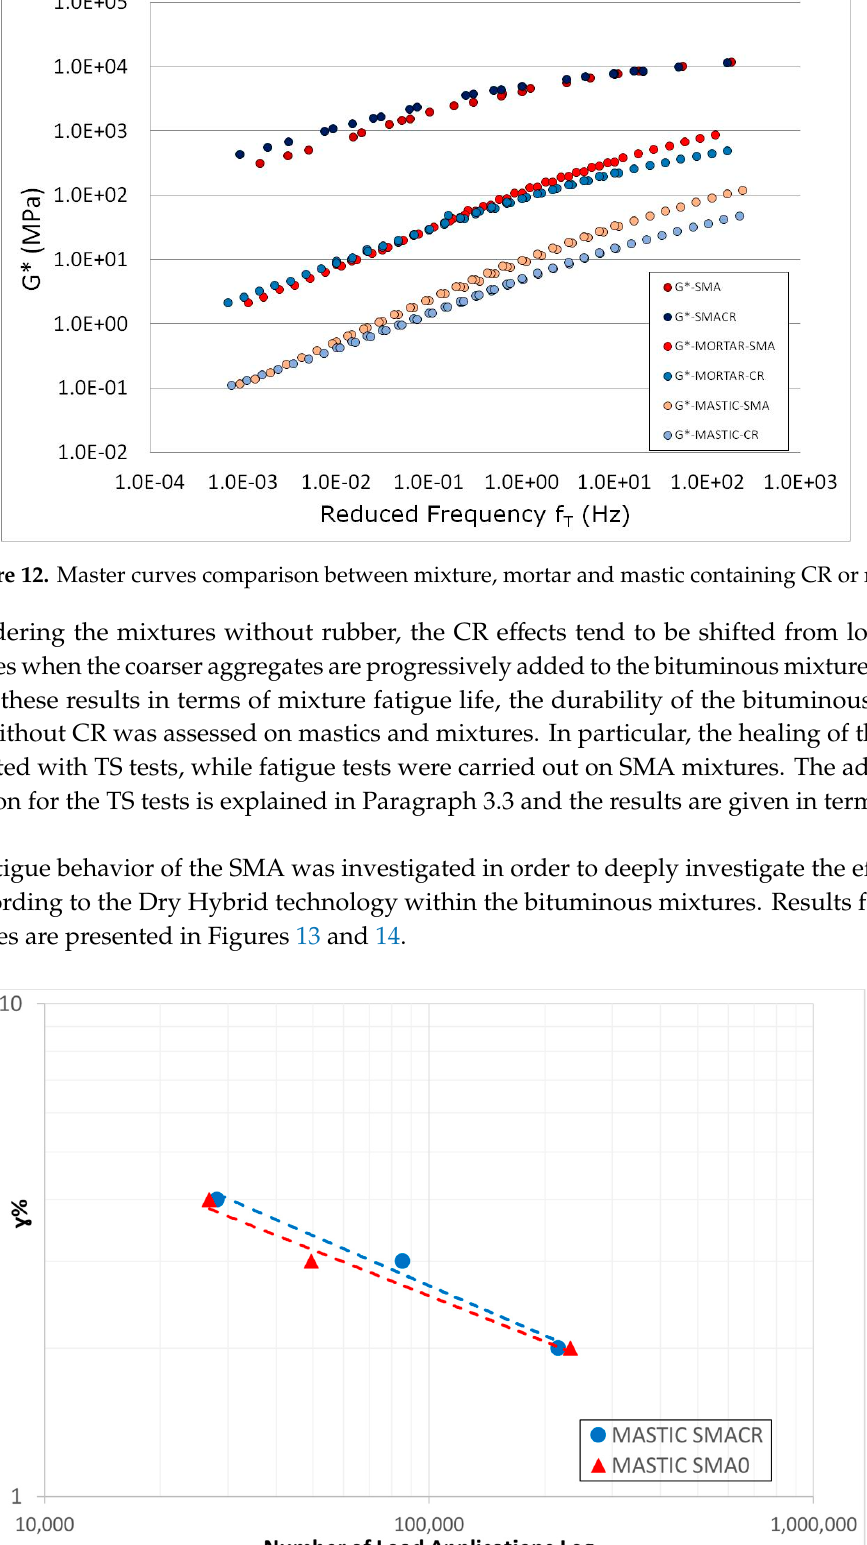
Figure 14. Mixtures indirect tensile fatigue test (ITFT) test comparison. From the analysis of results, the increase in number of load applications for both SMACR mastic and mixture is clear. The presence of CR involves the improvement of mastic and mixture durability regardless the applied stress. The phenomenon is confirmed in terms of healing (TS test on mastics) and fatigue life (ITFT on mixtures). It is worth noting that in terms of the stiffness modulus, both mixtures show comparable values (3259 MPa for SMACR and 3188 MPa for SMA0 at 20 °C, calculated according to EN 12697-26 Annex C standard). In the light of the above, the adopted stress levels produced comparable horizontal deformations in the samples, validating the adopted test conditions. 6. Conclusions The main objective of this study was to evaluate the rheo-mechanical properties of mastics, mortars and mixtures containing fine CR according to the dry-hybrid technology, through a multiscale approach. In particular from the obtained results the following conclusions can be drawn: